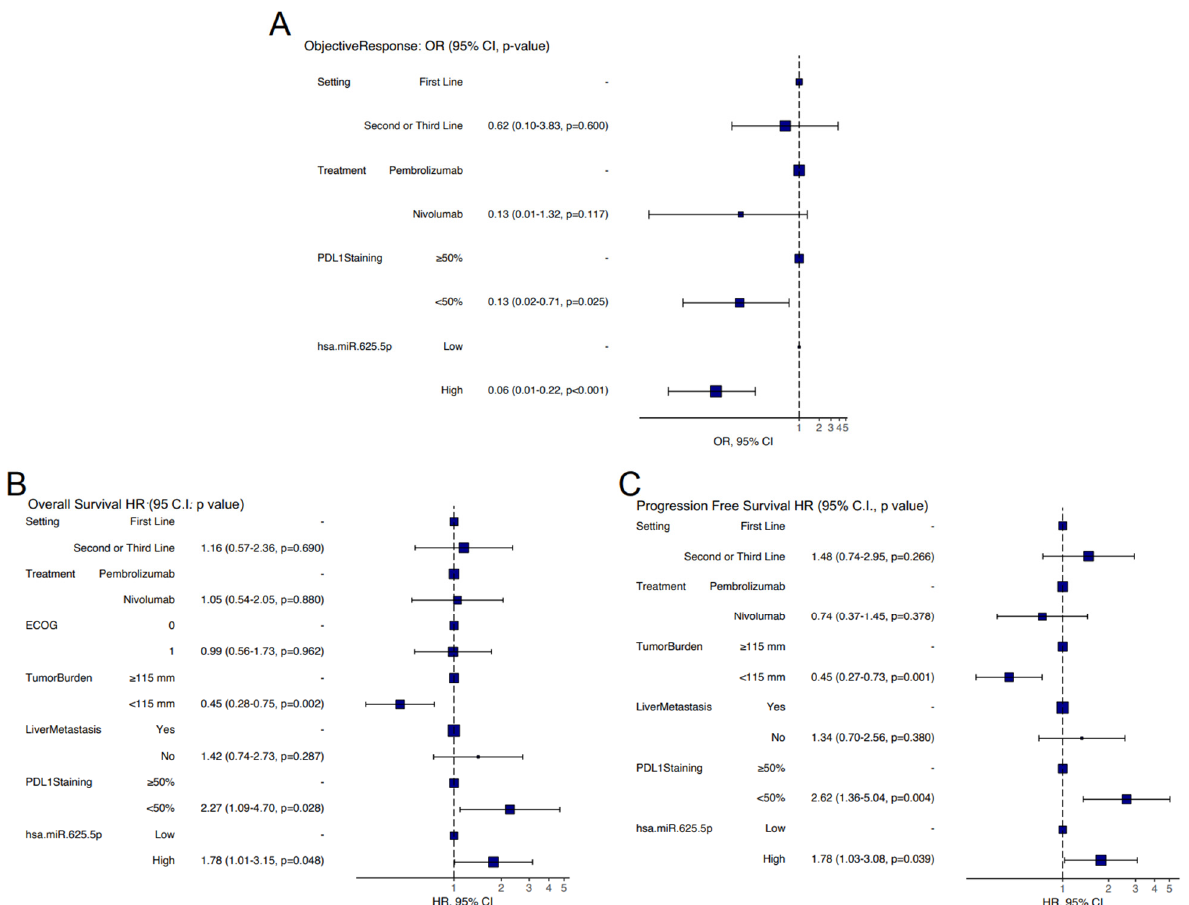
Figure 4. Multivariate analysis. Forest plot representing odd ratios and 95% C.I. for OR ( A ) hazard ratio and 95% C.I. for OS ( B ) and PFS ( C ) in multivariate analysis. ratio and 95% C.I. for OS ( B ) and PFS ( C ) in multivariate